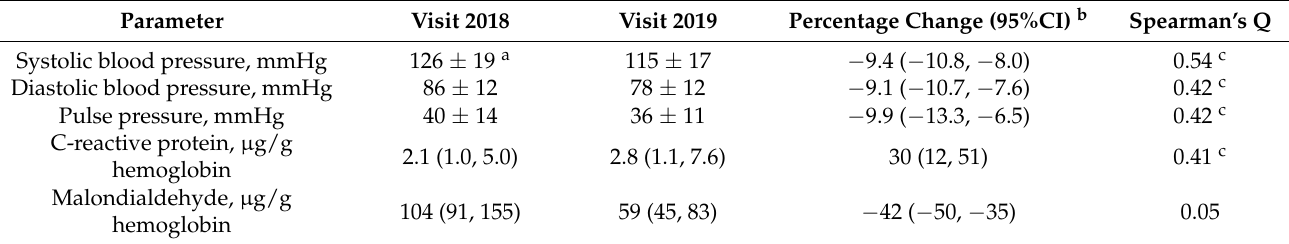
Table 2. Blood pressure and DBS biomarker at baseline and